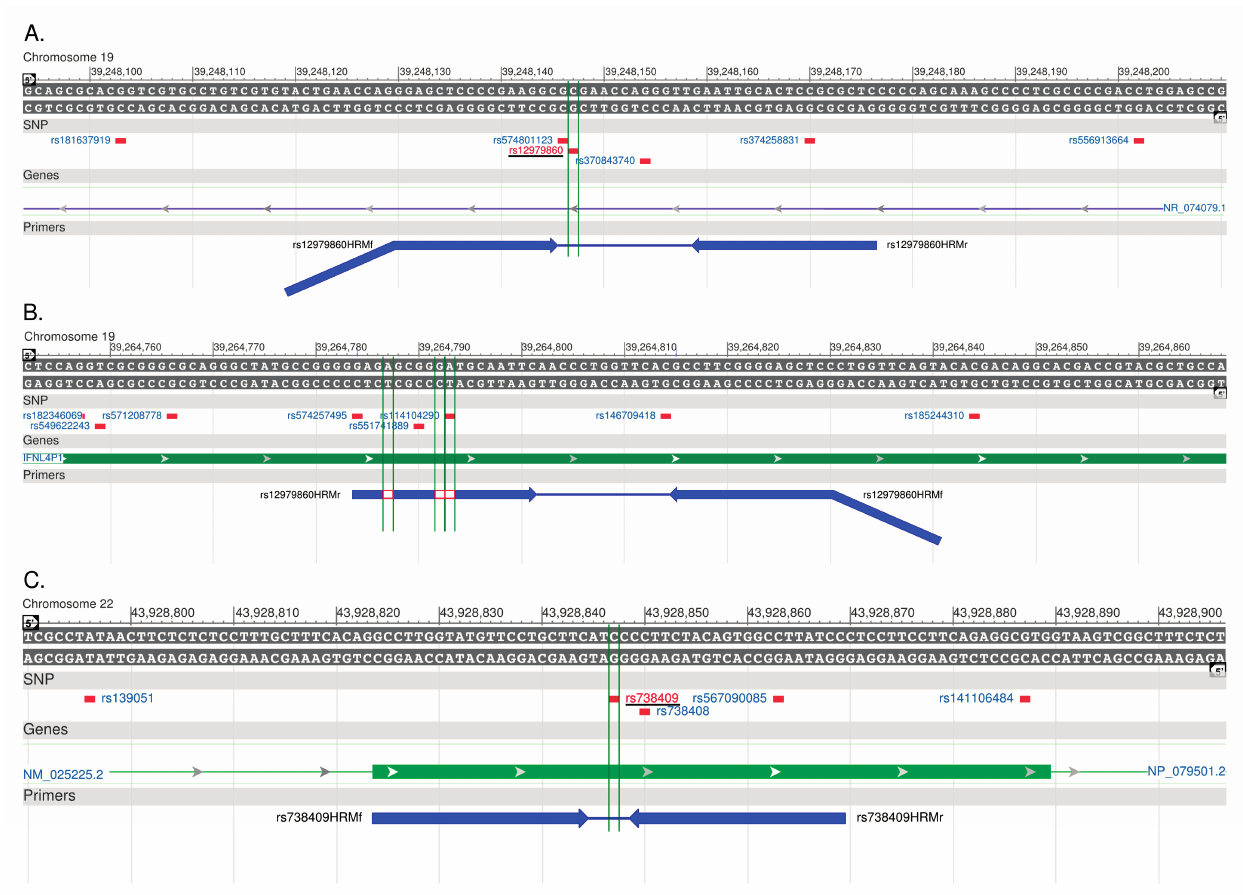
Figure 4. Positions of high-resolution melting analysis primers relative to human genome. ( A , C ) Specific binding positions of rs12979860 and rs738409 HRM primers, respectively; ( B ) Partial complementarity of rs12979860 HRM primers with an unintended target sequence in the IL28B region. Primers are shown in solid arrows. The added 5 ′ tail of the reverse rs12979860 HRM primer is shown as a diagonal solid line. Mismatches of the forward rs12979860 HRM primer to the genomic sequence are shown in open rectangles. SNPs in the respective regions are shown. Target variants are